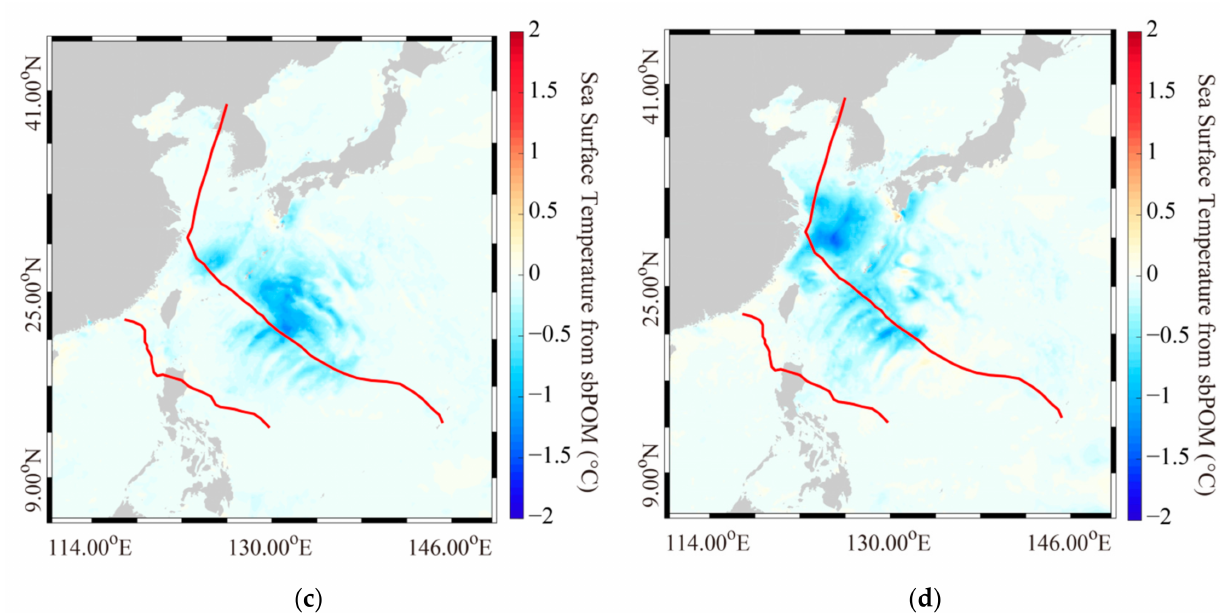
Figure 10. Daily average SSTs simulated using the sbPOM during the Chan-hom and Linfa typhoons on 7–11 July 2015. ( a ) Results from 7 July minus results from 8 July; ( b ) results from 8 July minus results from 9 July; ( c ) results from 9 July minus results from 10 July; ( d ) results from 10 July minus results from 11 July.